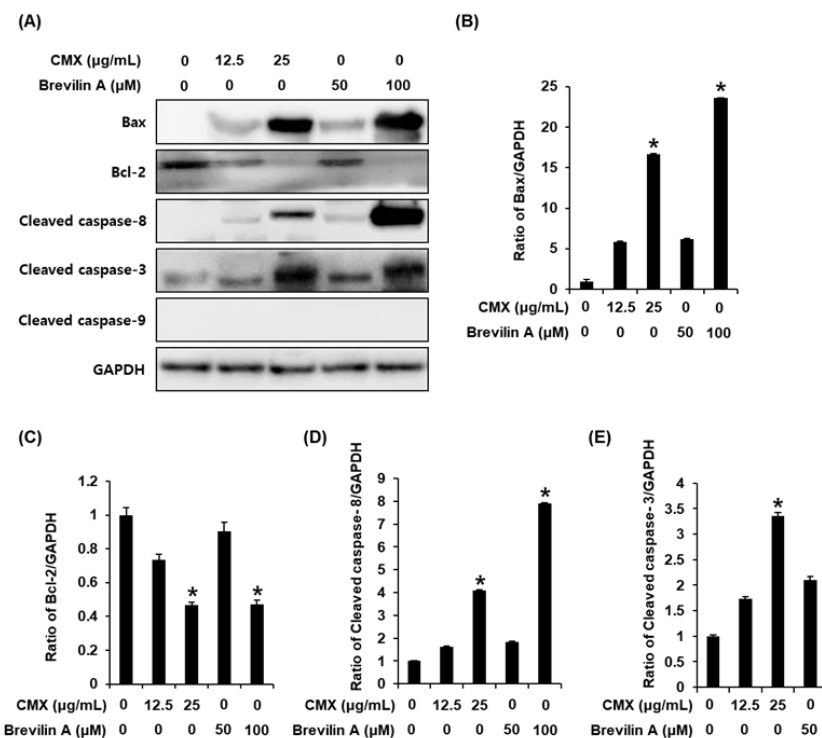
Figure 7. The effects of Centipeda minima (CMX) and brevilin A on the expression of apoptosis- related proteins in AGS human gastric cancer cells. ( A ) Representative images of western blotting for Bax, Bcl-2, cleaved caspase-8, cleaved caspase-3, cleaved caspase-9, and GAPDH in AGS cells treated with CMX and brevilin A for 24 h. ( B – E ) Bar graphs presenting the densitometric quantification of the respective western blot bands. The experiment was performed in triplicate. The error bars represent the standard deviation of samples (n = 3). * p < 0.05 compared with that of the control.